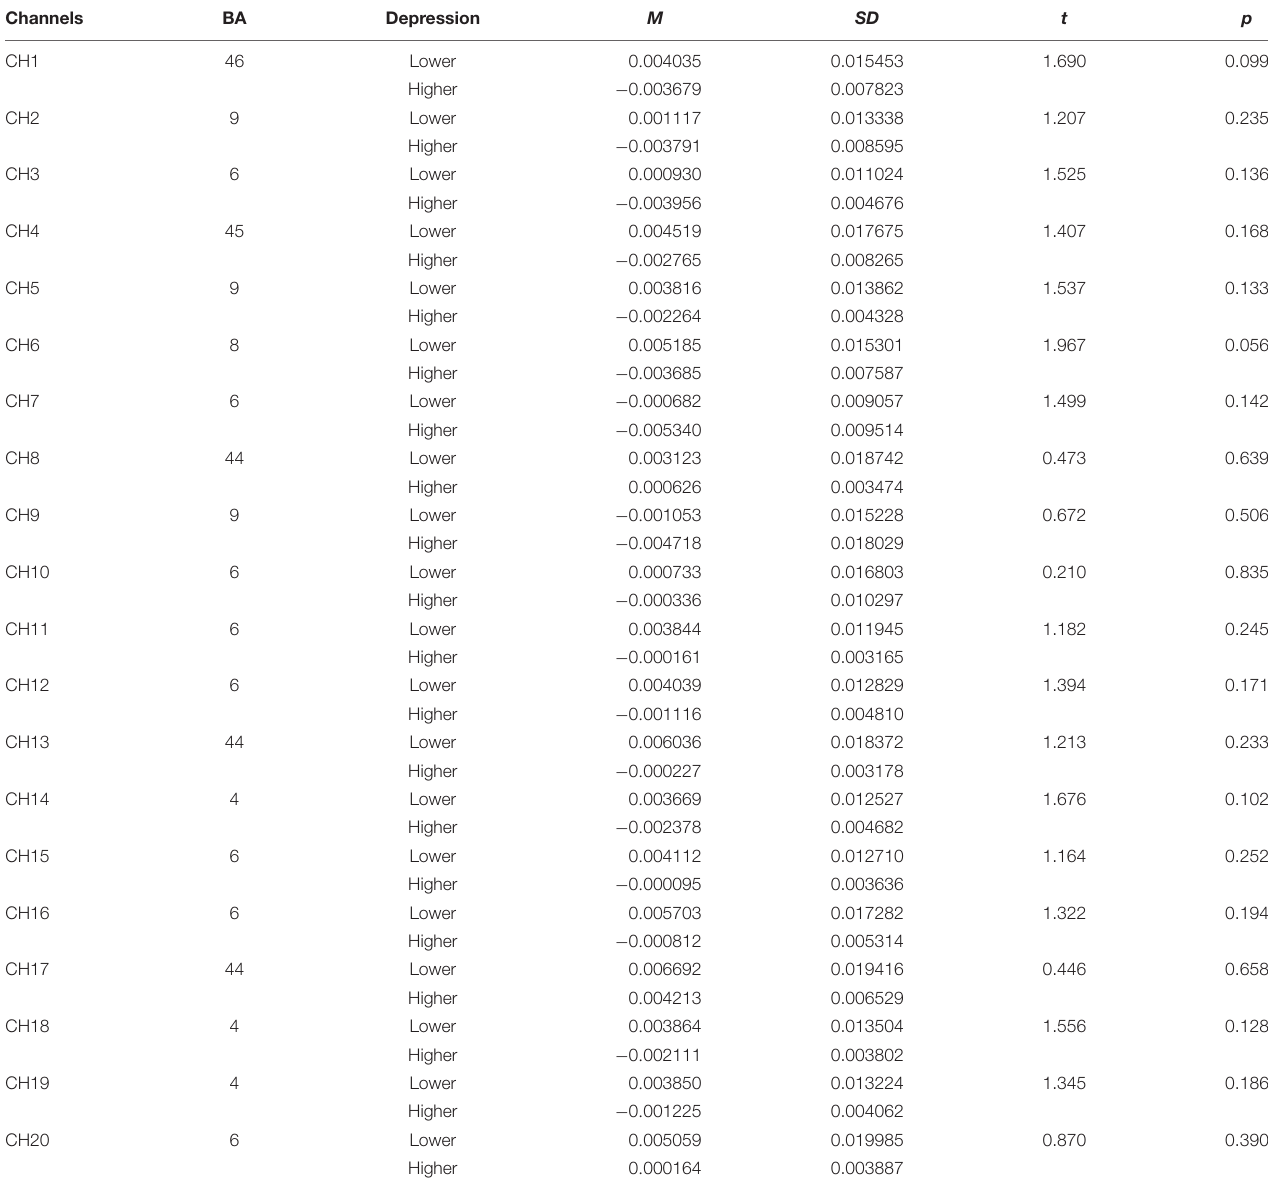
TABLE 4 | The comparison of brain activation between higher and lower groups in rotation stage for object mirrored images (HbO).